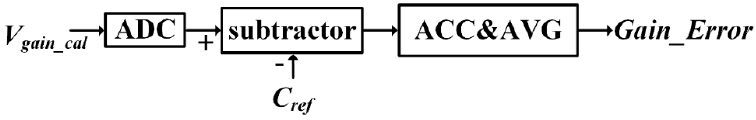
Figure 7. Gain error extraction diagram.